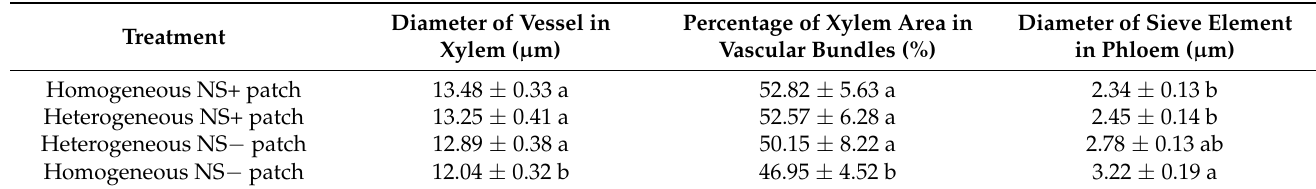
Table 4. Comparison of the leaf crosscutting structures of Kentucky bluegrass ramets in different patches under different treatments.